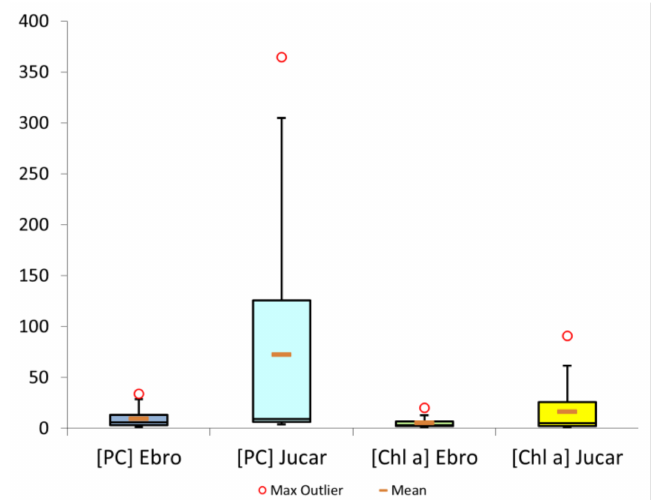
Figure 3. Comparison between PC and Chl-a values in Ebro and Jucar basins in µ g L − 1 . On the other hand, the monitoring and alert level values, classified according to the WHO [3] for all the reservoirs studied, are presented in Table